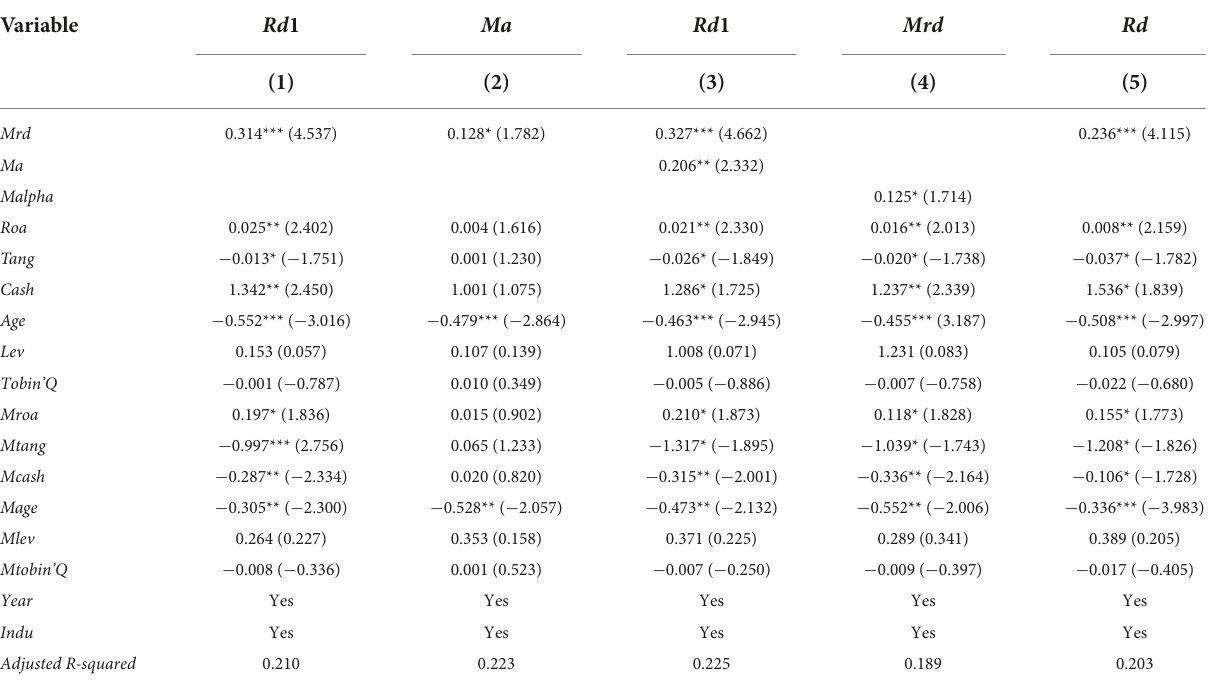
TABLE 4 Robustness